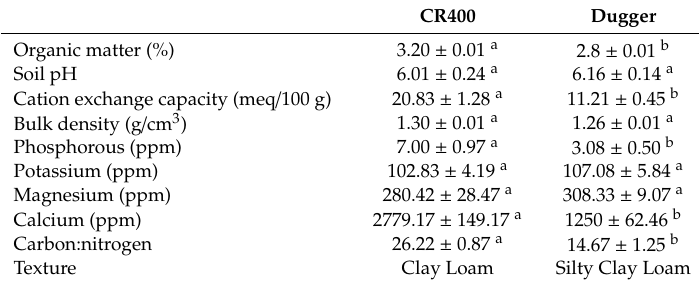
Table 2. Site soil